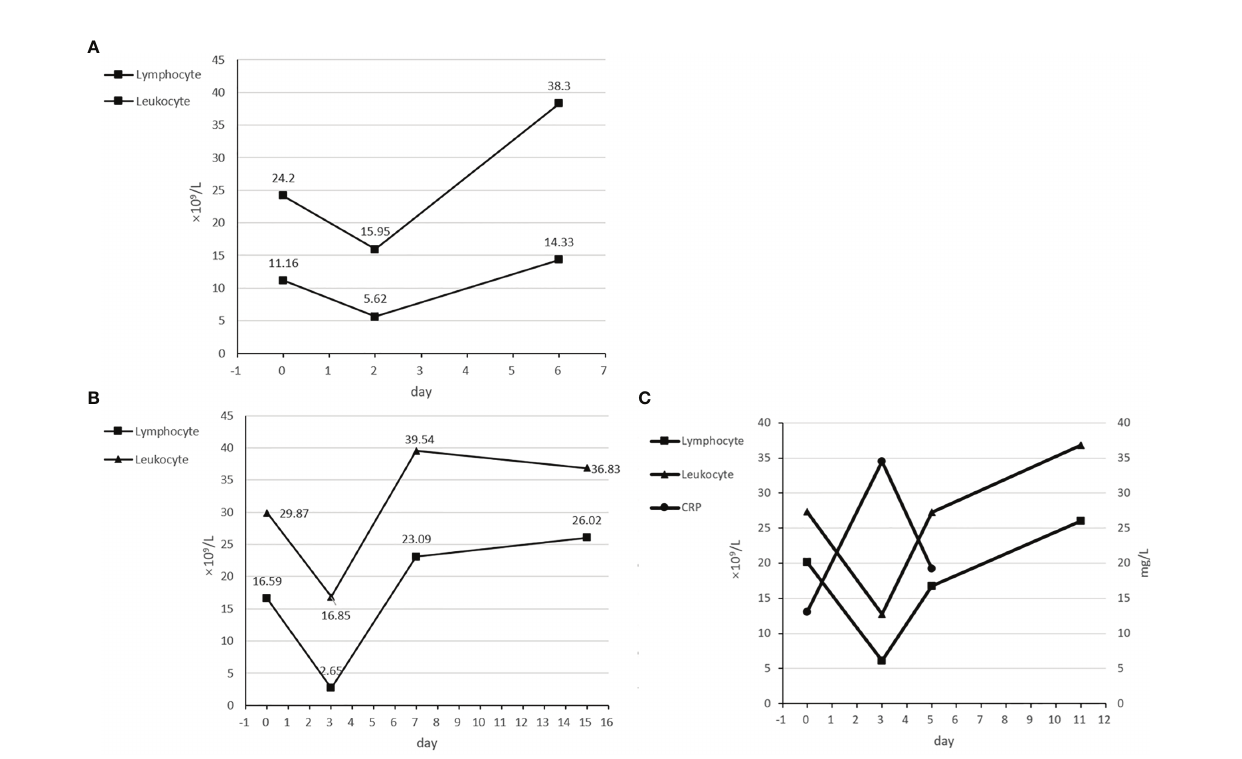
FIGURE 2 | (A) Transient decrease of leukocytes and lymphocytes in the 1st cycle of case 2. (B) Transient decrease of leukocytes and lymphocytes in the 1st cycle of case 3. (C) Transient increase of CRP and decrease of leukocytes and lymphocytes in the 2nd cycle of case